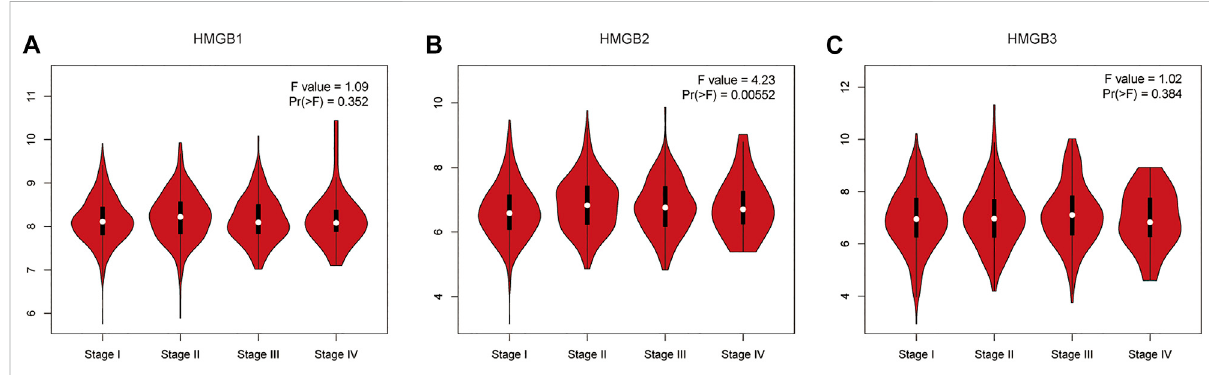
FIGURE 3 The relationship between mRNA expression of HMGB family members and tumor stage in patients with NSCLC (GEPIA). The mRNA expression of HMGB2 was signi fi cantly related to tumor stage (B) , while the mRNA expression of HMGB1/3 was not associated with tumor stage (A,C)